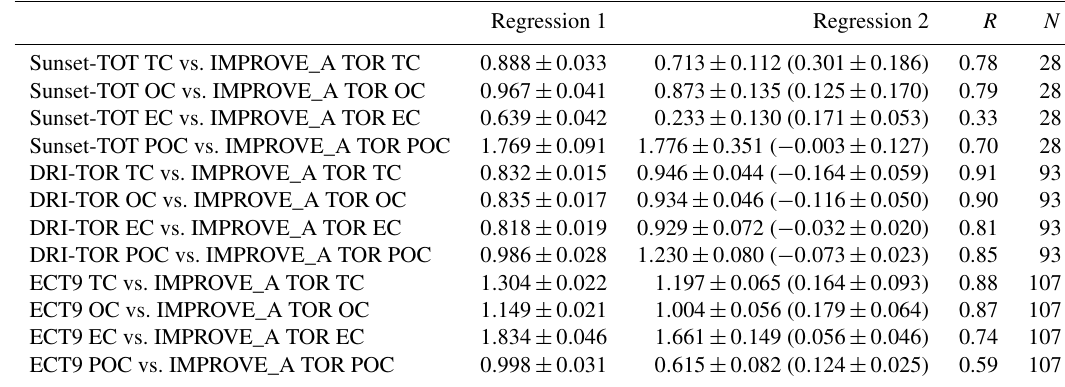
Figure 5. Relationship between the monthly averaged CAPMoN vapour adsorption corrected and uncorrected measurements for (a) TC, (b) OC, (c) EC, and (d) POC. Black solid markers represent the TOR measurements (2008–2015) analyzed by the DRI analyzer (i.e., DRI-TOR). Red open markers represent the TOT measurements before 2008 analyzed by the Sunset analyzer (i.e., Sunset-TOT). The red line represents the best-fitted linear regression of all the DRI-TOR measurements through the origin. All the corresponding statistics (i.e., best-fitted slope, correlation coefficient, total number of measurement points) are included in the legend. Table 2. Regression results (slope, correlation coefficient, and total number of points) obtained when fitting various CABM (ECT9) and CAPMoN (Sunset-TOT & DRI-TOR) carbonaceous mass concentration time series against IMPROVE (IMPROVE_A TOR) measurements. IMPROVE_A TOR and ECT9 measurements cover the period from 2005 to 2015. Sunset-TOT and DRI-TOR measurements cover the periods for 2005–2008 and 2008–2015, respectively. Regression 1 indicates the best-fitted slope through the origin. Regression 2 is the best-fitted slope with intercept (in